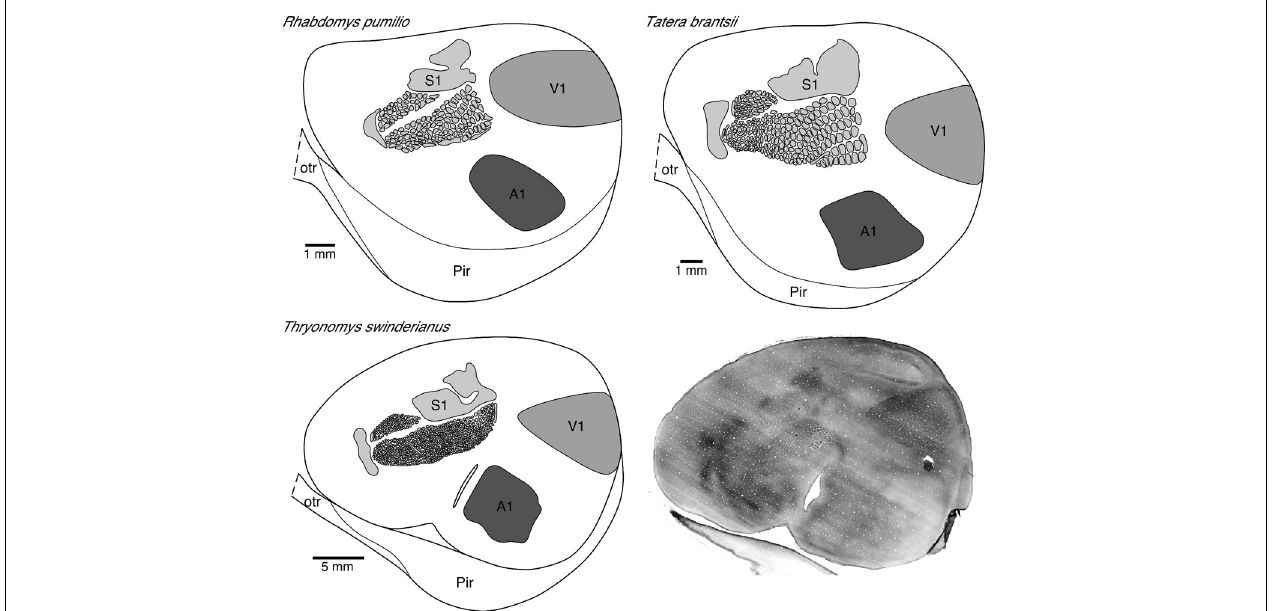
FIGURE 1 | Photomicrograph (bottom right) of a tangential section cut from a “flat-mount” preparation of the entire left hemisphere of the greater cane rat that was processed for cytochrome oxidase reactivity.